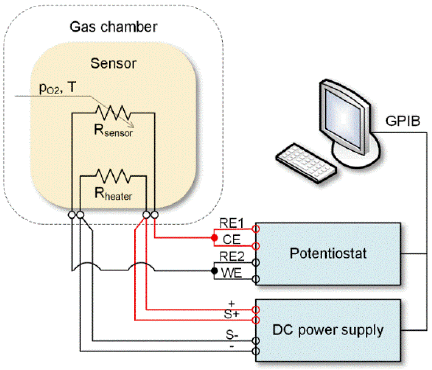
Figure 2. The temperature-controlled conductance measurement setup.